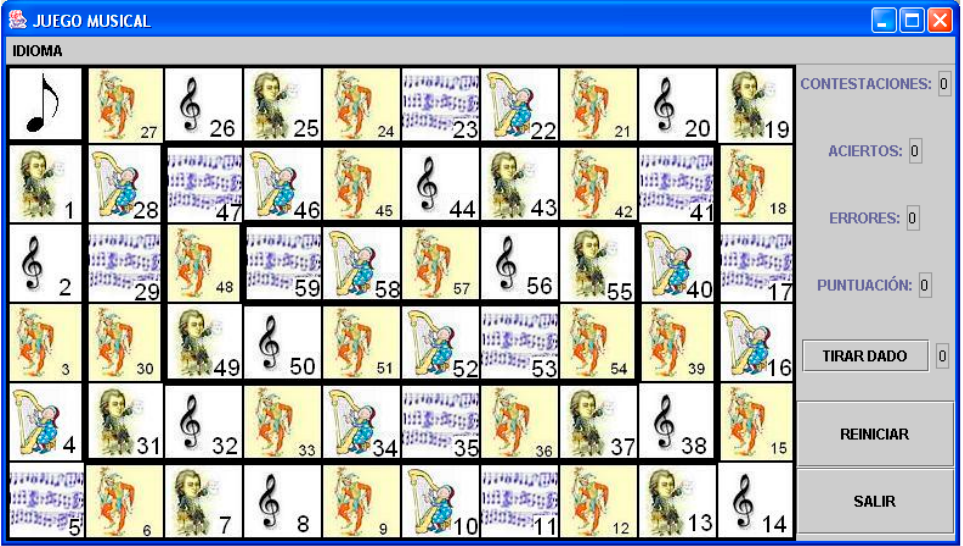
Figure 1. Digital board “Musichao, The Musical Educational Game”.